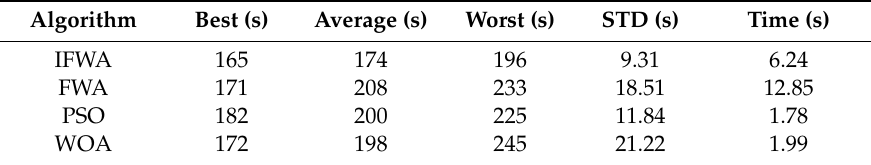
Table 6. Comparisons of the optimizations in